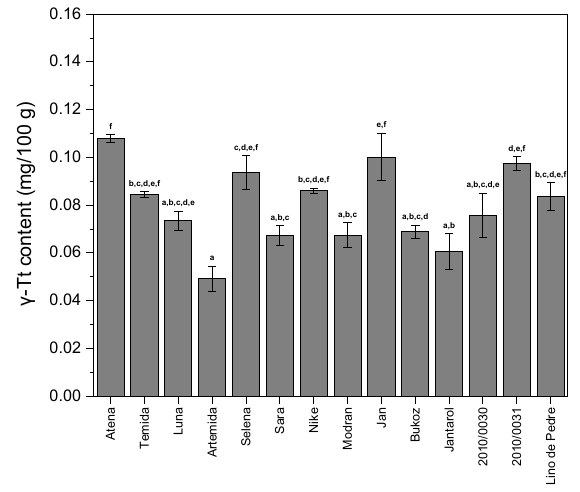
Fig. 3 Plastochromanol-8 (PC-8) content in accessions of flax (Group I). Different letters indicate significant differences (Tukey’s HSD multiple comparison test, α = 0.05).